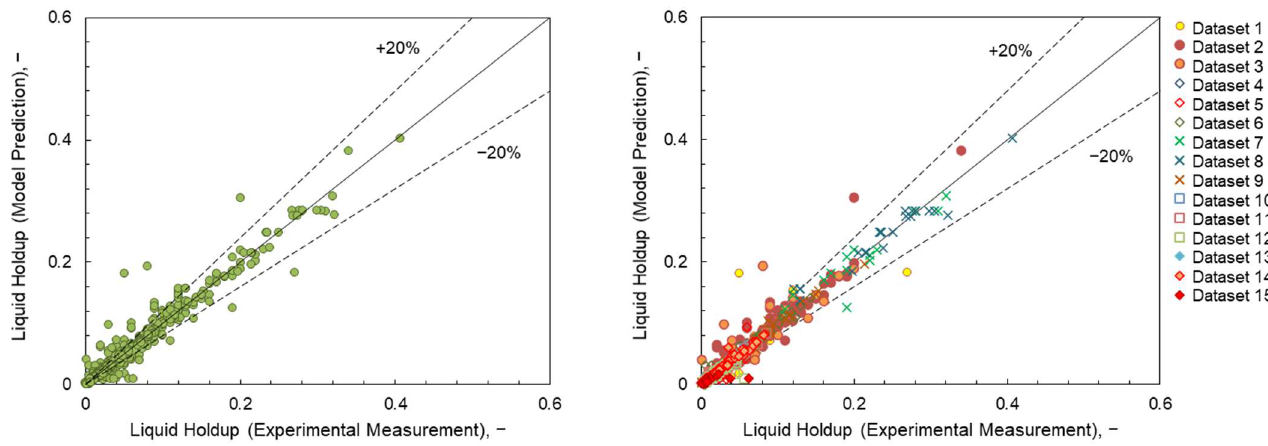
Figure 9. Comparison of experimental measurement and predictions for the pressure gradient.